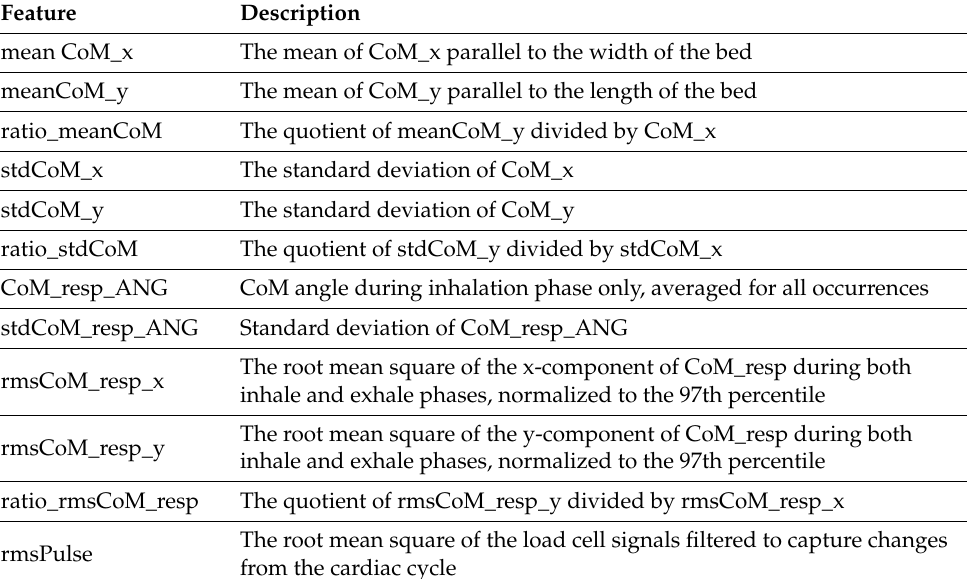
Table 1. Features calculated from the load cell